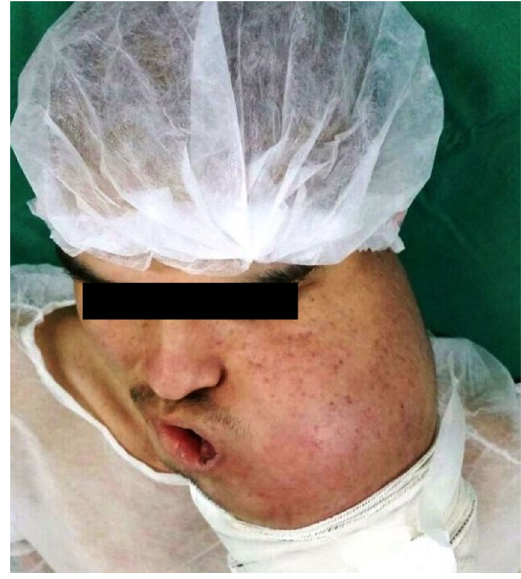
Figure 5 Craniocaudal view of the patient showing a sig- nificant increase in tumor mass after eight sessions of